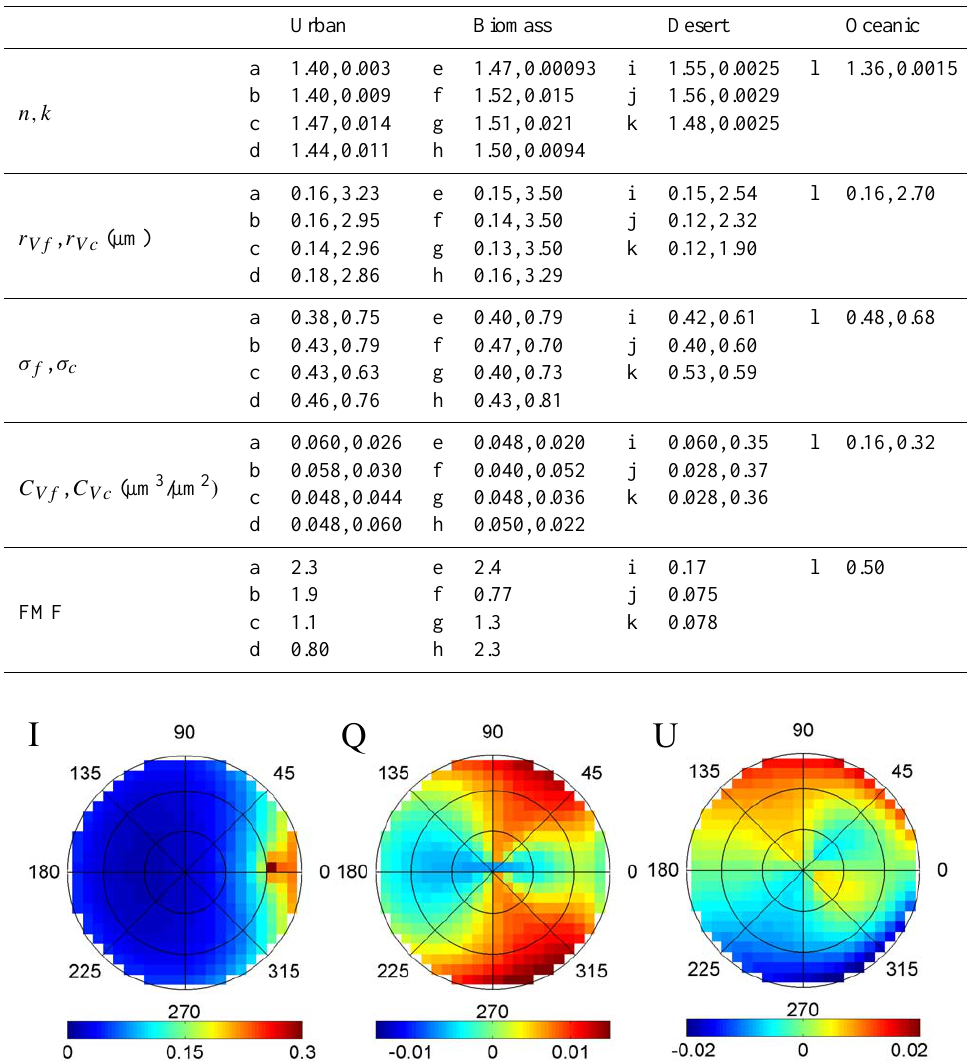
Table 1. Microphysical properties of the four representative aerosol types observed at different locations. Urban aerosol: Greenbelt, USA, (a), Paris, France (b), Mexico City, Mexico (c), Maldives (d). Biomass burning aerosol: Amazonian forest, Brazil (e), South American cerrado, Brazil (f), African Savanna, Zambia (g), Boreal forest, USA/Canada (h). Desert dust aerosol: Bahrain, Persian Gulf (i), Solar Village, Saudi